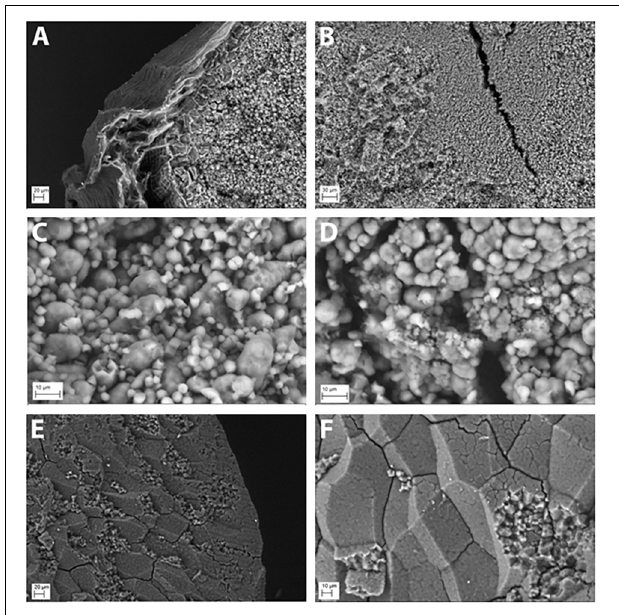
FIGURE 2 | Starch granule morphology of representative hp-SSIIa-shr shrunken (SS28) and hp-SSIIa-op opaque (SS5) lines compared with the control. The starch granules of hp-SSIIa-shr, (A) showing the edge and (B) the middle section of an unpolished grain, demonstrating that severely distorted seed development is due to aborted starch granule formation. The starch granules of hp-SSIIa-op, (C) showing mixture of rounded compound and simple starch granules, (D) with some very small starch granules in the middle of the grain. The parent Nipponbare is used as a control, (E) showing the edge of a polished grain (F) and the middle showing compact and angular compound starch